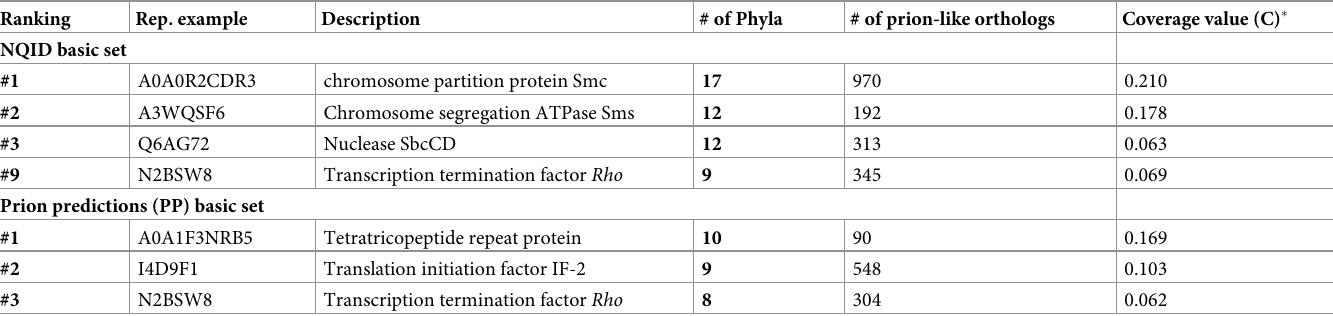
Table 2. Lists of the top-three families that occur across the greatest number of phyla, for both NQID and prion prediction sets of proteins. Ranking Rep. example